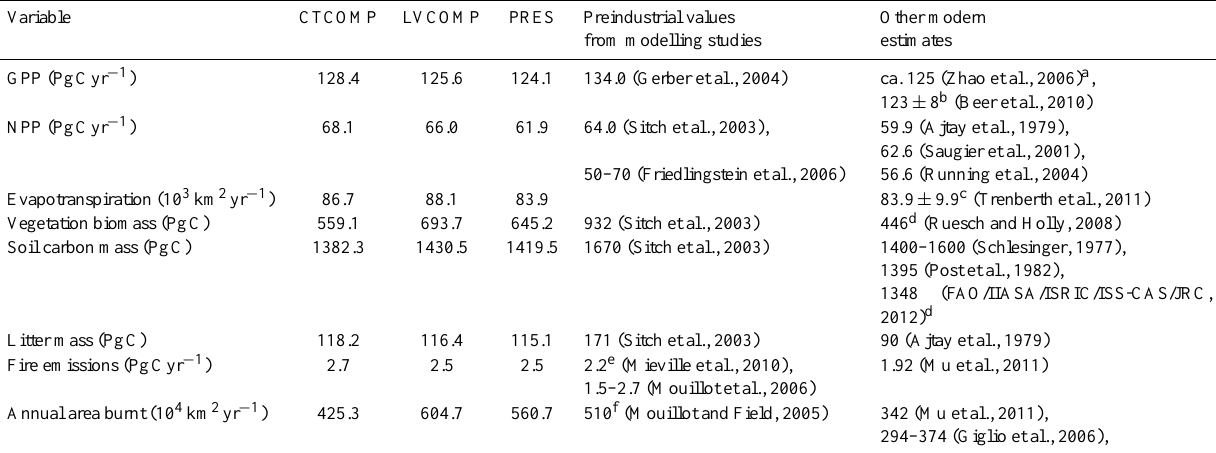
a MODIS-derivedLAIdrivenwithNCEPreanalysis. b Estimateformodernperiodincludingtheeffectofanthropogeniclanduseandelevated CO 2 concentrations. c Basedoneightreanalysesfortheperiod 2002–2008,exceptERA-40,whichwasforthe1990s(Trenberthetal.,2011). d InterpolatedtothesameresolutionandlandmaskasCTEM. e Fortheyear1900usingtheburntareaestimateofMouillotand Field(2005). f